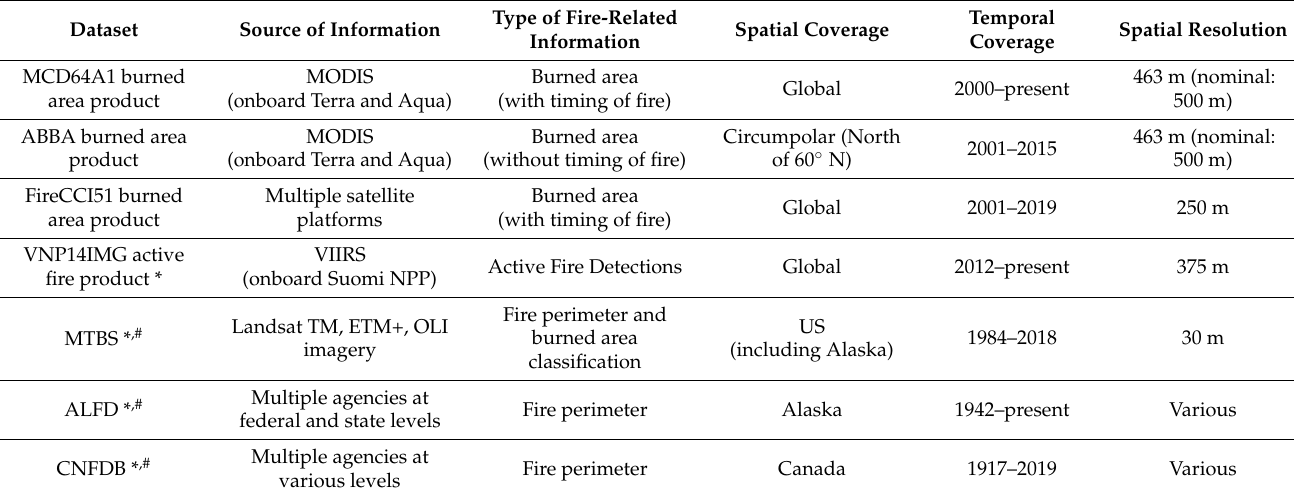
Table 1. List of the fire products that were used in this project. Datasets that are marked by * are those that were used as reference. Datasets that are marked by # are those whose production involved expert